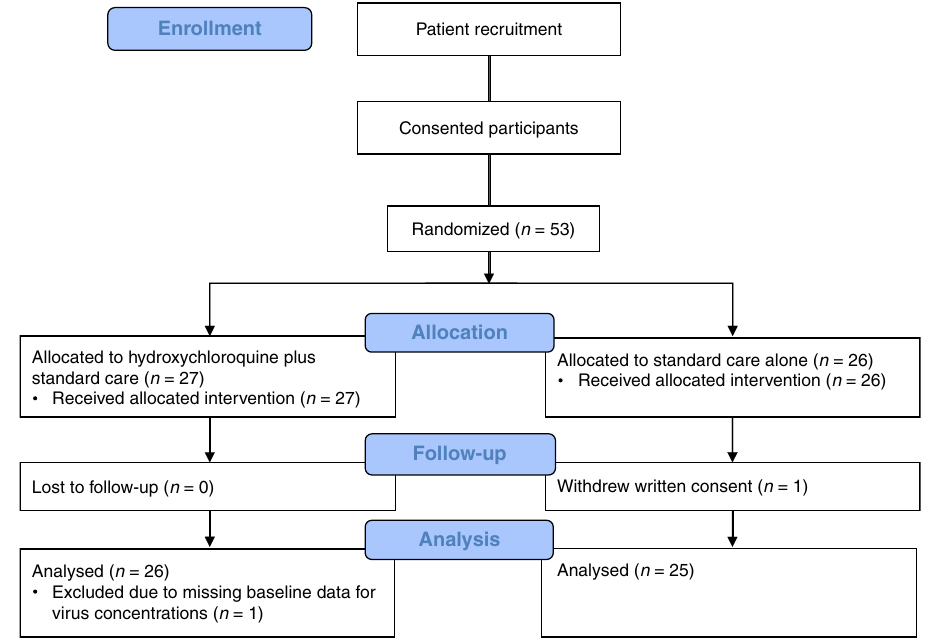
Fig. 1 CONSORT diagram. Flow diagram of the NO COVID-19 Study according to CONsolidated Standards Of Reporting Trials